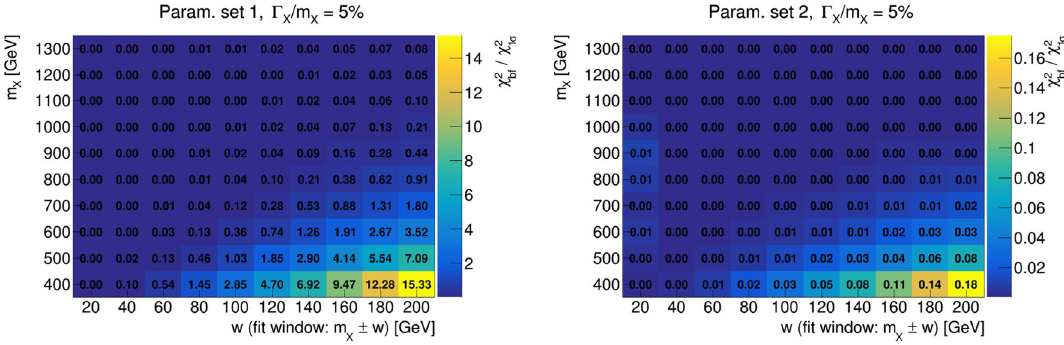
aries, and a red circle marks the PM input point ( m X , (cid:3) X )